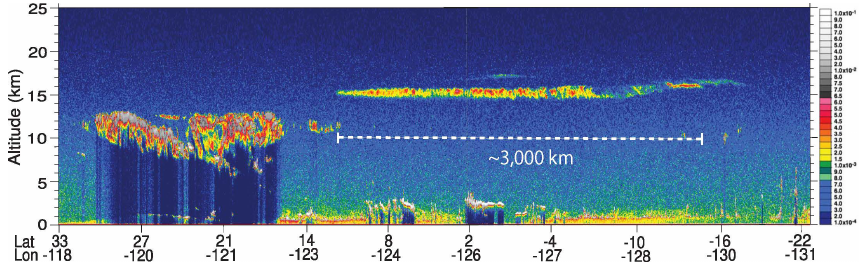
Fig. 1. Extensive cirrus cloud observed by CALIPSO on 28 January 2009 at approximately 10:00UTC. The cloud extended from approxi- mately (12 ◦ N, 123 ◦ W) to (15 ◦ S, 129 ◦ W). The image shows the CALIOP lidar vertical profile backscatter along the orbit